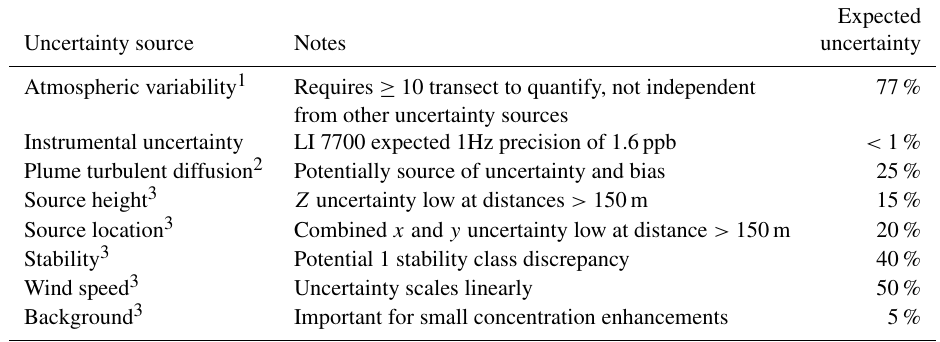
Table 6. Sources and magnitude of uncertainty in IGM emission estimates.